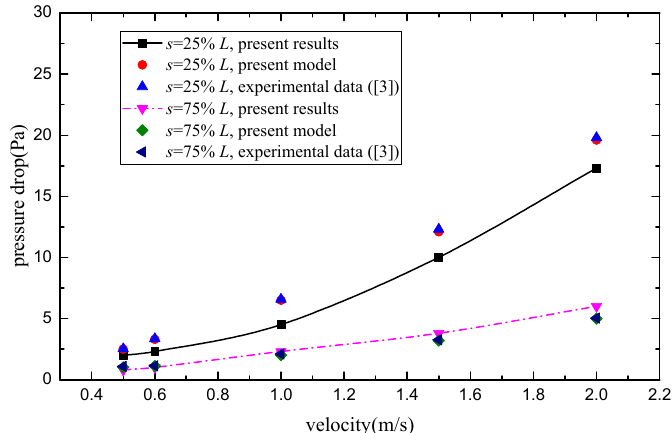
Figure 9. Comparisons of the pressure drop for the #2 plate fin heat sink.